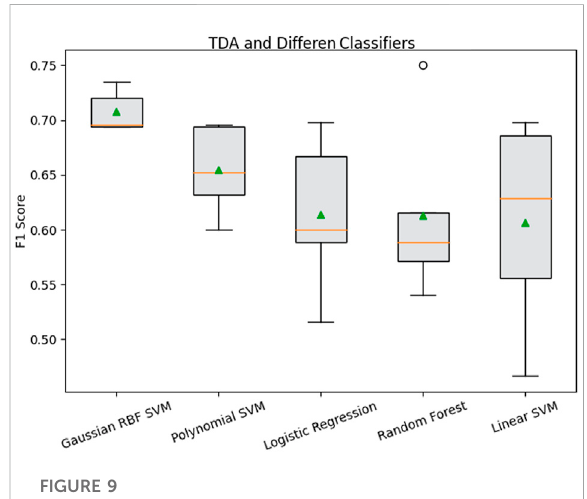
FIGURE 9 Performance evaluation and the effect of the classi fi er on sickness detection using the TDA feature descriptor.